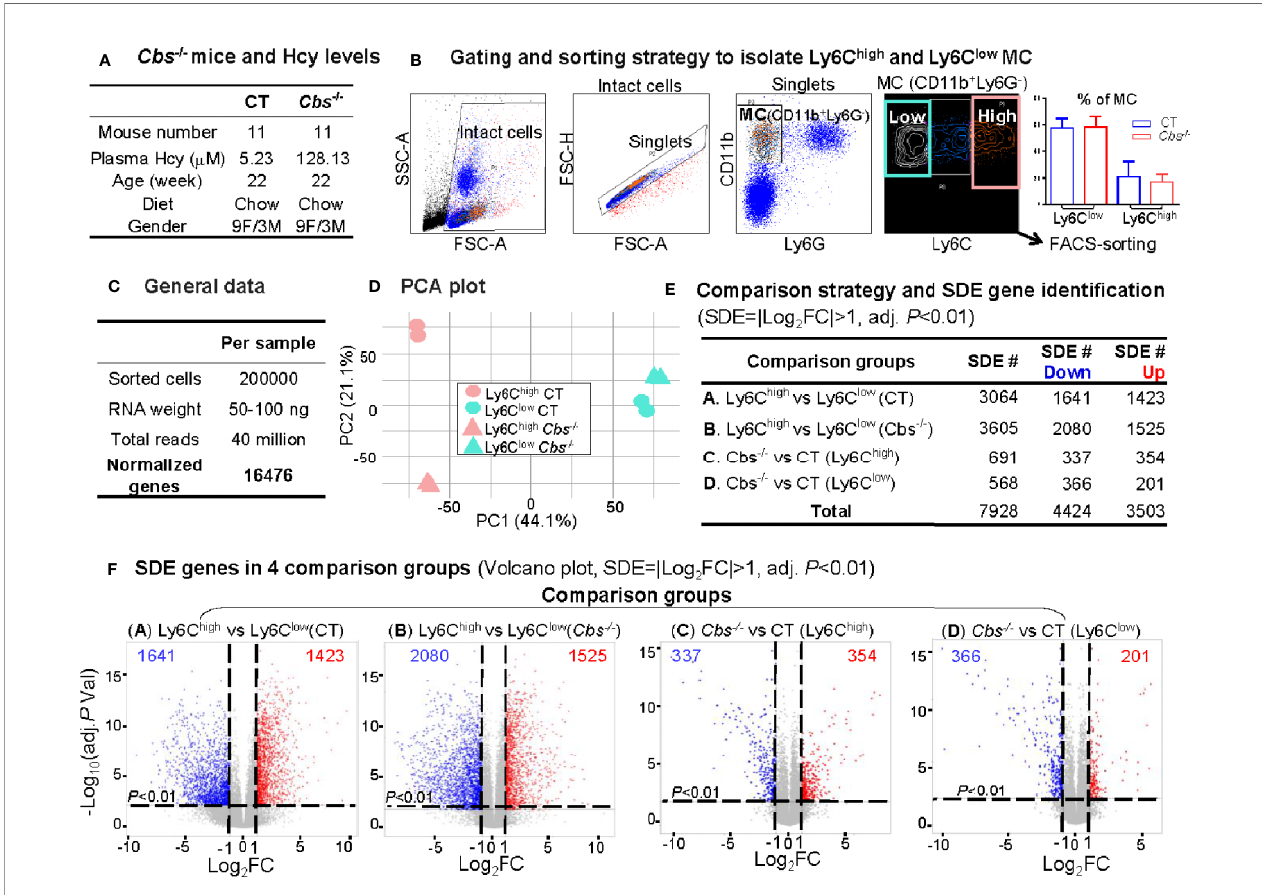
FIGURE 2 | RNA-Seq analysis and SDE gene identi fi cation from blood Ly6C high and Ly6C low MC of C57/BL6 control and Cbs -/- mice. (A) Cbs -/- mice and Hcy levels. Eleven mice were used in each group. Severe HHcy were determined in Cbs -/- mice (plasma Hcy 128.13 m mol/L). (B) Gating and sorting strategy to isolate Ly6C high and Ly6C low MC. Mouse white blood cell were prepared from peripheral blood and stained with antibody against CD11b, Ly6G and Ly6C and subjected for fl ow cytometry cell sorting. Intact cells (72.8%) were recognized based on higher FSC-A (larger size). Singlets (71.0%) were identi fi ed by using FSC-H versus FSC-A appeared on a diagonal. CD11b + Ly6G - cells (11.0%) were selected as MC. MC subsets (CD11b + Ly6G - Ly6C high , and CD11b + Ly6G - Ly6C low ) were sorted based on Ly6C levels. The quanti fi cation of MC was used fl ow cytometry analysis for Ly6C high and Ly6C low MC in CT and Cbs -/- . (C) General data. 100 ng mRNA were obtained from 100,000 sorted cells and achieved around 30 millionreads and 16,487 normalized genes per sample by mRNA-Seq analysis. (D) PCA plot. PCA analysis incorporated 8 samples from 4 groups of MC subsets {Ly6C high (CT), Ly6C low (CT), Ly6C high ( Cbs -/- ) and Ly6C low ( Cbs -/- ), n=2} using the R software package Seurat. PC1 versus PC2 demonstrates the close transcriptional proximity. PC1, PC2 and PC3 variance is 44.1%, 21.1% and 12.9%. PC1 (44.1%) means that the difference on the x-axis can explain 44.1% of the overall result. (E) Comparison strategy and SDE gene identi fi cation. We performed four group comparison (A – D) and identi fi ed down-regulated and up-regulated SDE genes using the criteria of |Log 2 FC| more than 1 (2-FC) and adjusted P value less than 0.01. (F) SDE genes in four comparison groups. Volcano plot of all genes demonstrates the expression pattern of SDE genes in four comparison groups. Down-regulated SDE genes are highlighted in green and up-regulated in red (|Log 2 FC|>1, adj. P <0.01), with Log 2 FC as x-axis and − Log 10 (adjust P -value) as y-axis. MC, monocyte; CT, control; Cbs , cystathionine b -synthase; HHcy, Hyperhomocysteinemia; Hcy, homocysteine; FACS, fl uorescent-activated cell sorting; PCA, principal component analysis; PC, principal component; SDE, signi fi cantly differentially expressed; FC, fold